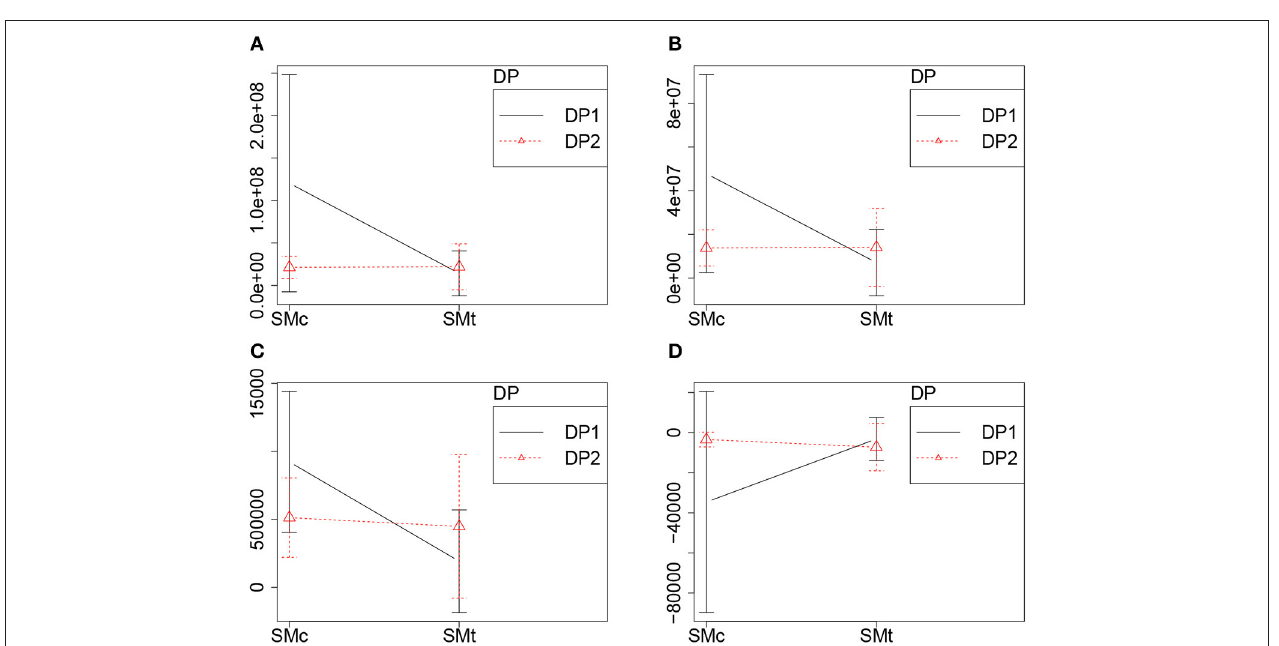
FIGURE 2 | Two factor interaction for (A) V , (B) S , (C) C , and (D) E . Horizontal axis represents the soil management factor and vertical axis the value of the Minkowski functional. The depth factor is represented by alternating colors.